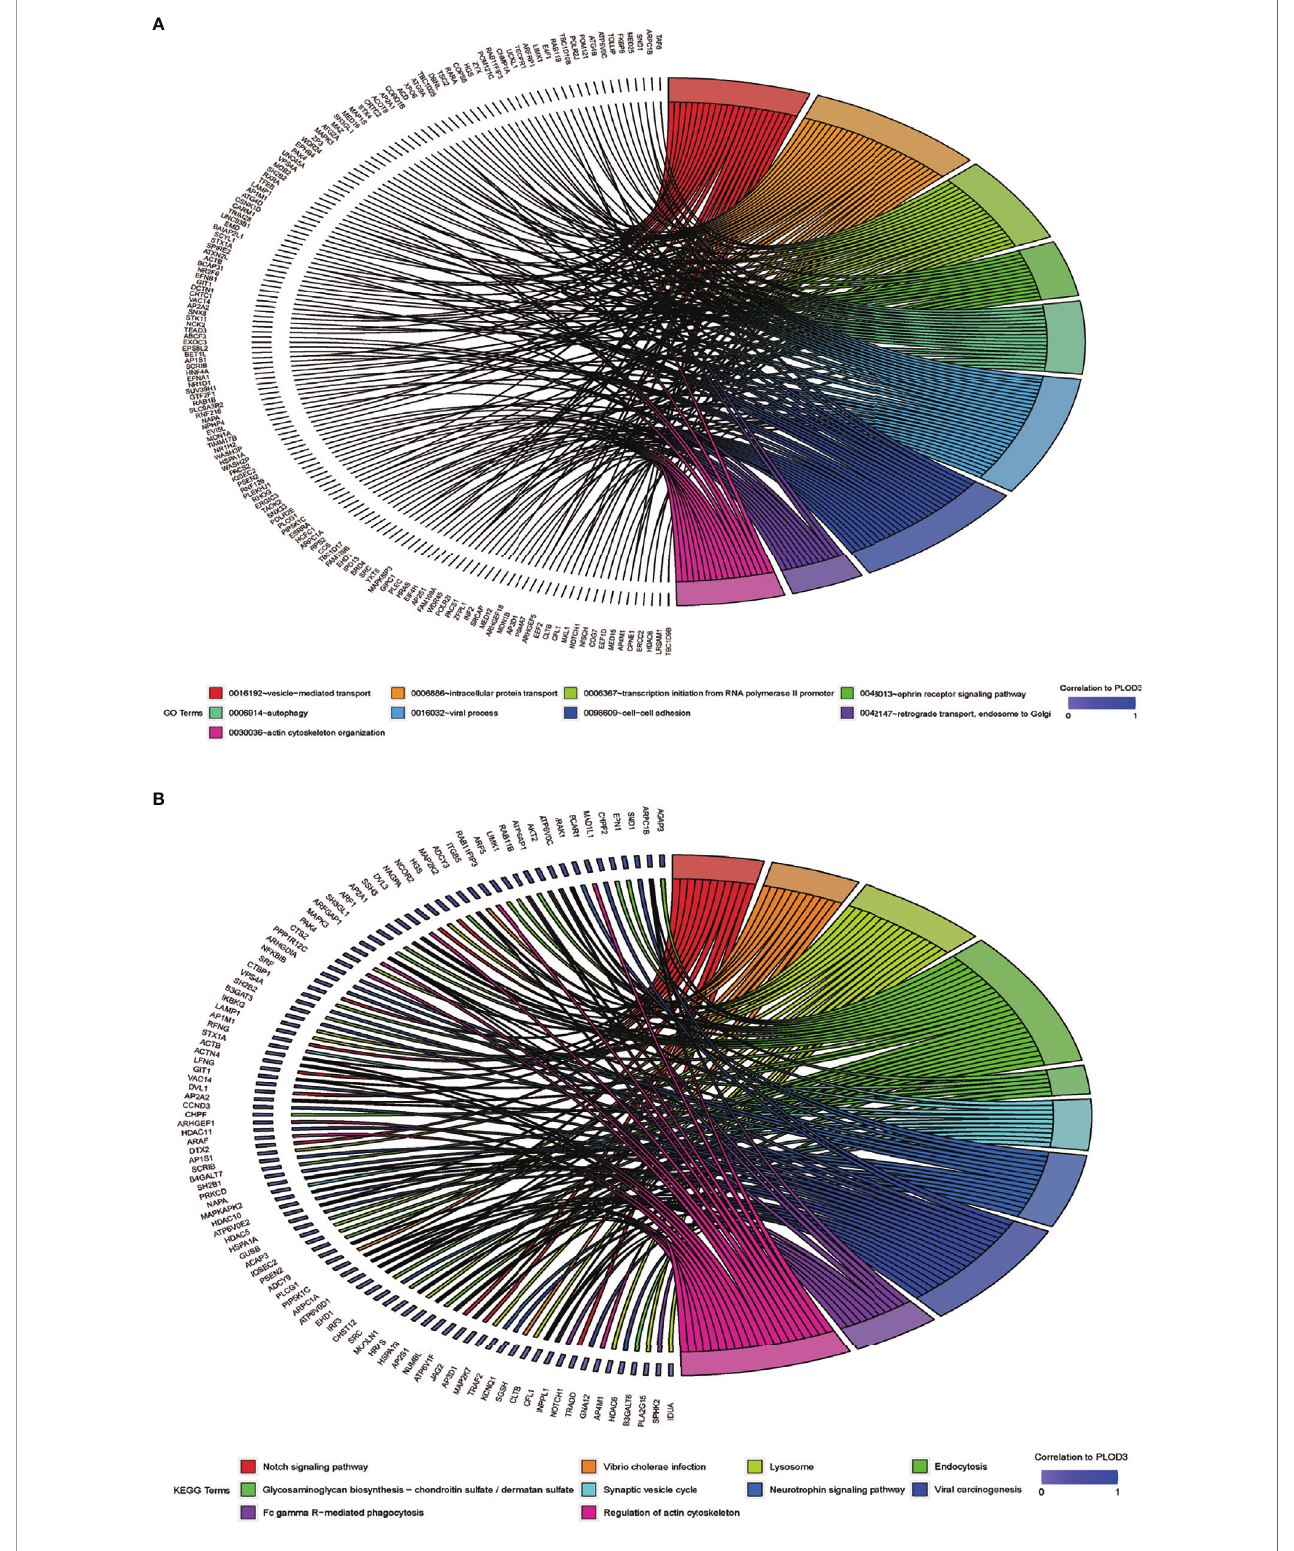
FIGURE 3 | (A) GO BP pathway analysis of PLOD3 related genes in CRC. (B) KEGG pathway analysis of PLOD3 related genes in